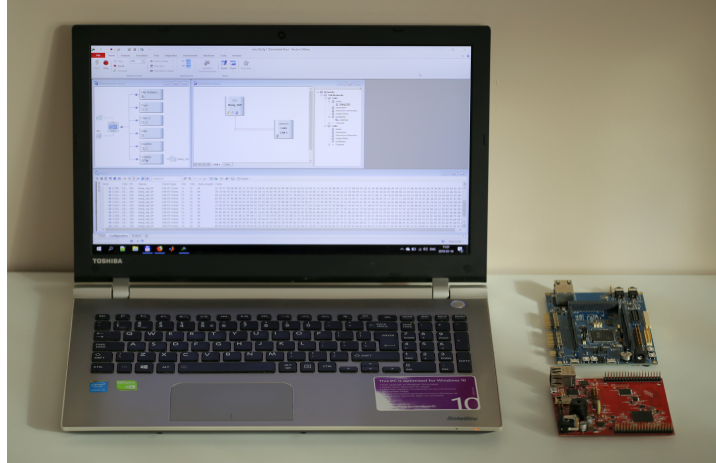
Figure 5. Components employed from our